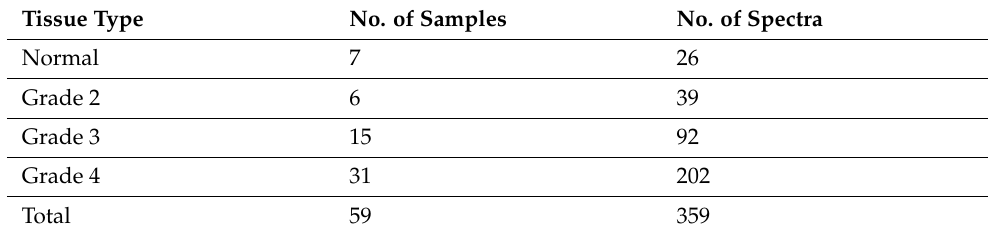
Table 1. Number of samples and spectra used in the classification